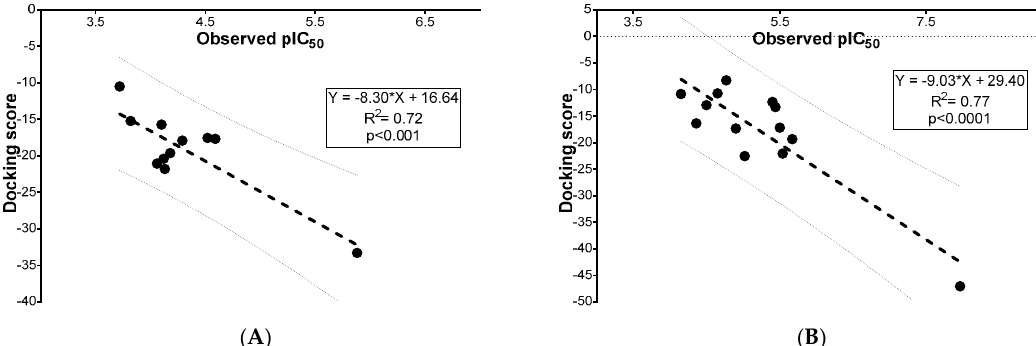
Figure 1. The linear regression between observed and predicted activity of synthesized flavone derivatives and positive control against ( A ) acetylcholinesterase (AChE) and ( B ) β -secretase Figure 2. The linear regression between observed activity and docking score against ( A ) (BACE-1). acetylcholinesterase (AChE) (values from B2 , B3, B5–8, D2, D4–6 and galantamine) and ( B ) β -secretase (BACE-1) (values from B2–8, D2–4, D7 , umibecestat and quercetin).